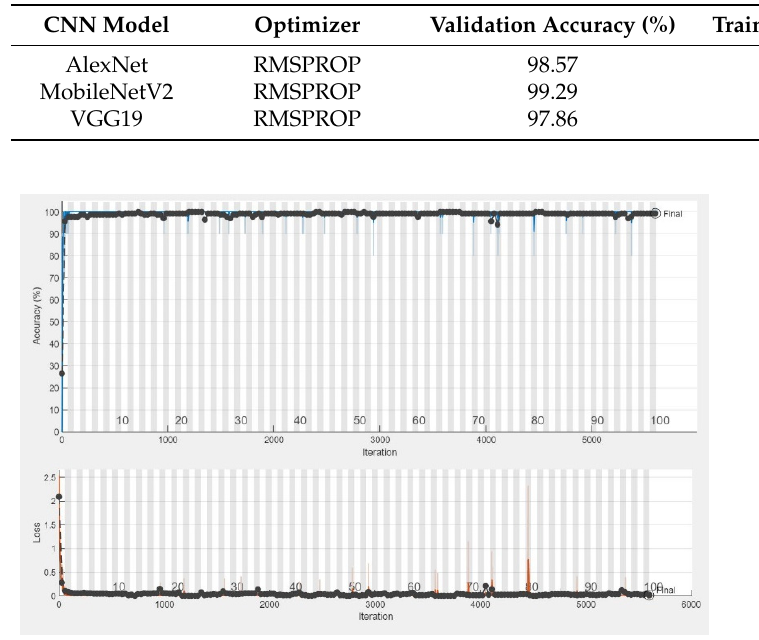
Figure 4. Training progress showing the validation accuracy of MobileNetV2.